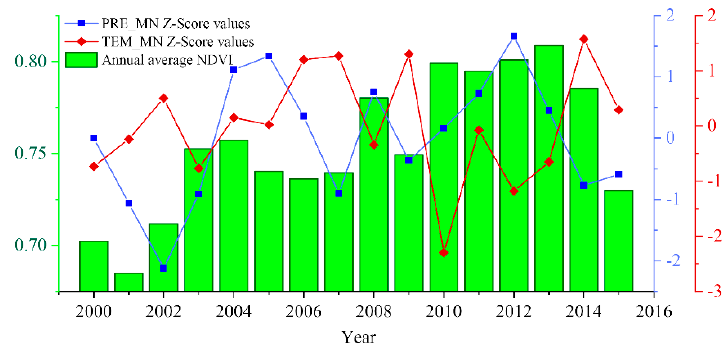
Figure 2. Average NDVI, precipitation anomaly, and temperature anomaly from 2000 to 2015.